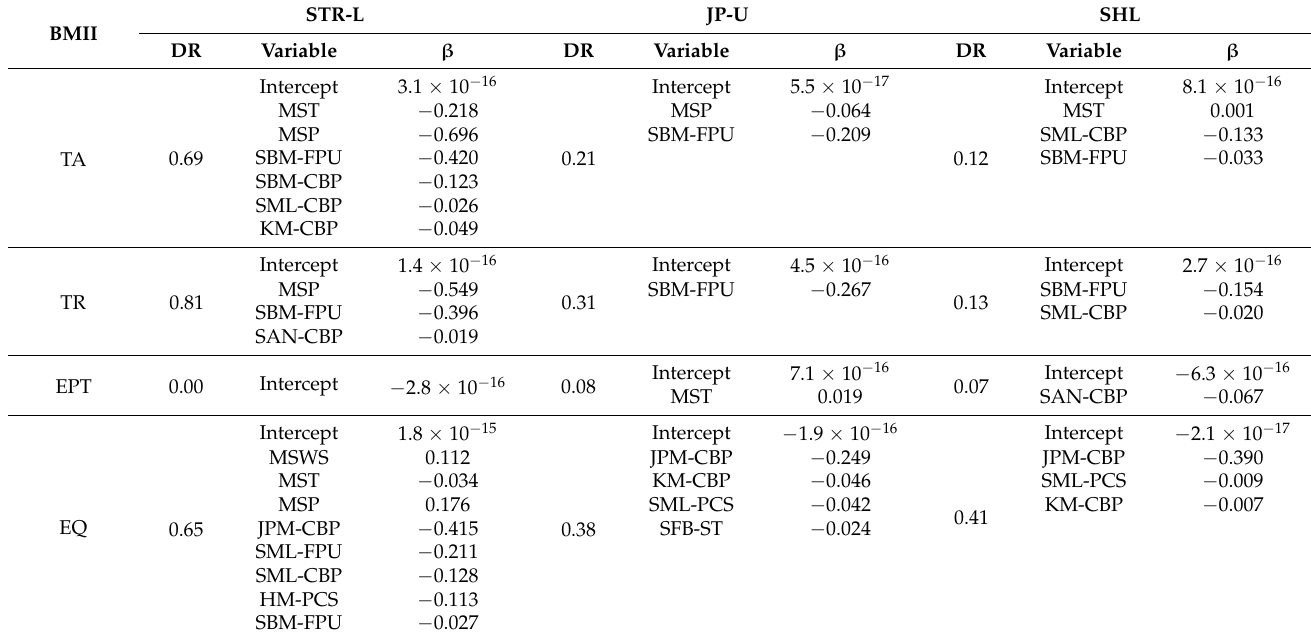
Table 2. Variables selected for the primary stream (STR-L, JP-U) and lake (SHL) sites for benthic macroinvertebrate indices (BMII; TA = total abundance; TR = taxon richness; EPT = percent EPT; EQ = equitability), including deviance ratio (DR) and coefficient magnitude; climatic variables selected shown in italics; variable codes defined in caption of Table 1.